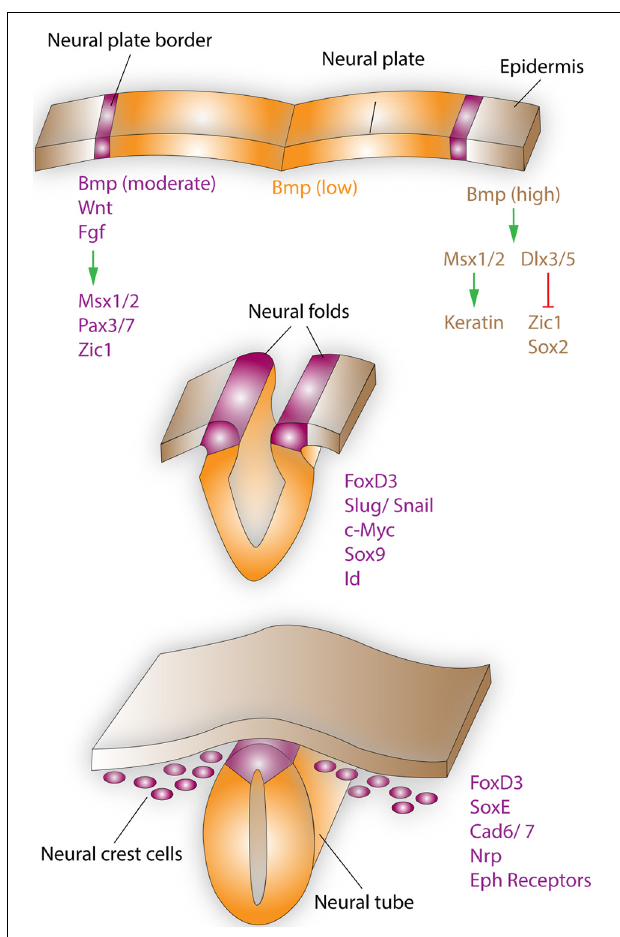
FIGURE 1 | Neural crest formation and migration during development. Neural crest regionalization (top) at the boundary of the neural plate and epidermis is a multi-step process. First, the border of the neural plate is set via secretion of neural plate inductive signals (Fgf, Bmp, and Wnt) from the ventral ectoderm and paraxial mesoderm (not shown). Anteriorly, the timing of Bmp and Wnt signaling contributes toward setting the boundaries between epidermis, prospective neural crest, and neural plate. In the narrow band, where Wnt signaling induces Bmp signaling and Wnt signaling is not subsequently turned off, NCCs are formed. Bmp, Wnt, and Fgf, which are secreted by the prospective neural crest, induce the expression of border regionalization genes such as Msx1/2, Pax3/7, and Zic1. In contrast, in the epidermis high concentrations of Bmp induce the expression Msx1/2, which promote keratin expression and Dlx3/5, which induce Zic1 and Sox2 expression. Neural crest specification (middle) starts with the expression of FoxD3, Slug/Snail, c-Myc, Sox9, and Id by the border cells, which prevents this region from becoming either neural plate or epidermal tissue. EMT, delamination, and migration of NCCs (bottom), is primarily induced by FoxD3, Snail, and Sox9. These factors are also capable of inducing a cranial neural crest fate for cells of the lateral neural tube, when ectopically expressed in this region. After delamination NCCs migrate to their respective destinations, regulated by the expression of proteins such as FoxD3, SoxE, Cad6/7, Nrp, and Eph receptors. Specifically, the head and facial structures are largely products of the cranial neural crest, which is a mixed population of cells, with about 10% of these cells being multipotent progenitor